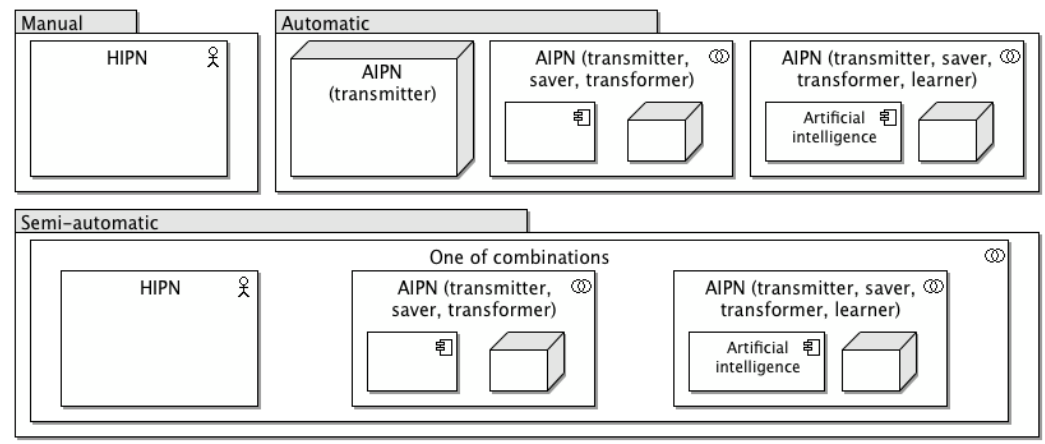
Figure 6 . Modes of information processing, grouping the types of IPNs participating in accomplishment of